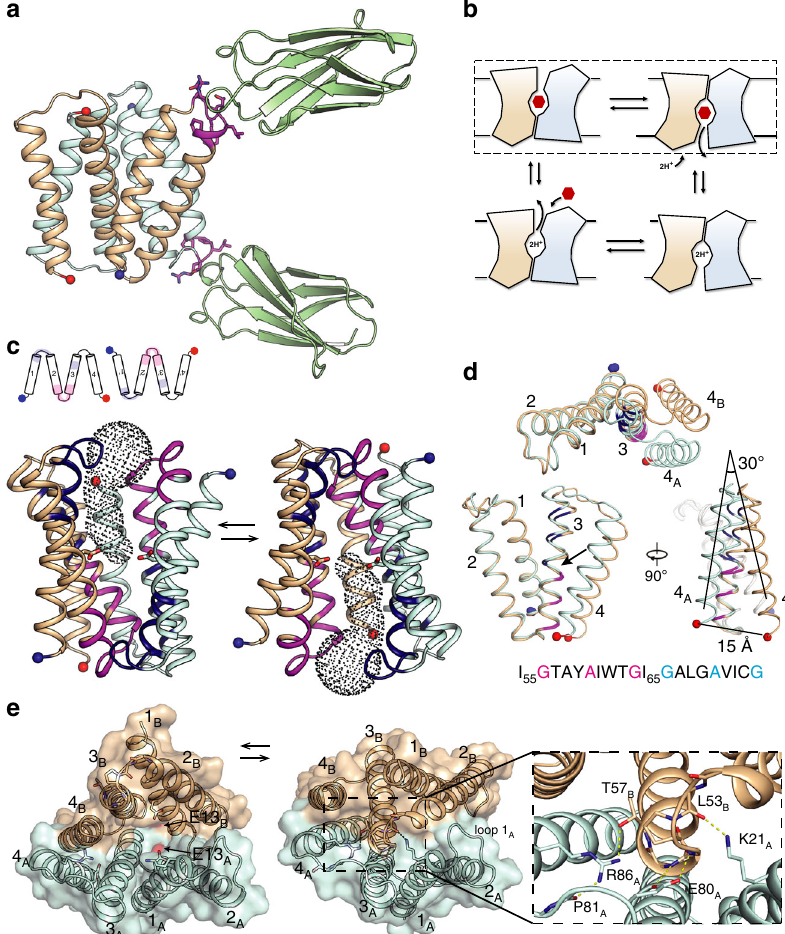
Fig. 3 Gdx-Clo structure and conformational exchange. a Structure of Gdx-Clo/monobody complex. Clo-L10 monobodies are shown in green. Transporter shown with subunit A in light blue and subunit B in tan. The N- and C-termini for each subunit are shown as blue and red spheres, respectively. Transporter residues that comprise the monobody binding interface are shown in magenta. b Cartoon schematic showing transport cycle for an antiparallel homodimer. The dashed box indicates the conformational exchange step highlighted in panel (c). c Changes in accessibility during conformational exchange. For both the upper diagram, and the lower three-dimensional structure, regions that alternate in solvent accessibility are shown in magenta (TM2, loop 2, and the fi rst GxxxAxxxG motif of TM3) and dark blue (TM1, loop 1, and second GxxxAxxxG motif of TM3). The N- and C-termini are shown as blue and red spheres. In the three-dimensional structure, E13 sidechains shown as sticks and solvent-accessible vestibule indicated with dots. d Overlay of Gdx-Clo A and B subunits aligned over C α 1 − 61. The sequence of TM3 is shown with GxxxAxxxG packing motifs colored in magenta and dark blue in structures and sequence. An arrow indicates I 65 .Three views are shown (counterclockwise from top): top-down view, view through the plane of the membrane (with GI 65 G indicated with an arrow), and rotated 90°. e Conformational exchange viewed from top down. E13 sidechains shown in red as surface representation and indicated with arrows. Sidechains that make polar contacts on the closed side of the transporter are shown as